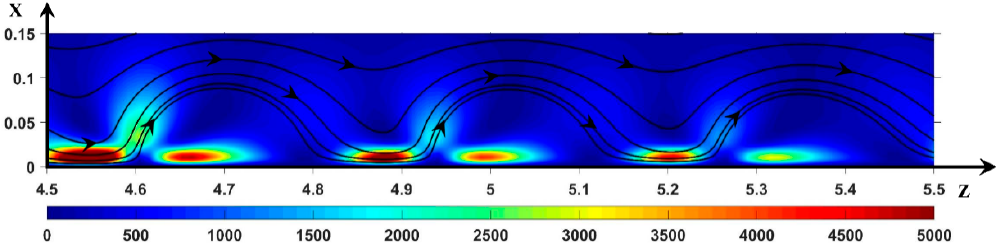
Figure 6. Color plot of the hydrodynamic kinetic energy E c . Black lines: static streamlines starting from the inlet. ∆Φ = 22, ν = 1/3 × 10 − 3 , D ± = ± = .